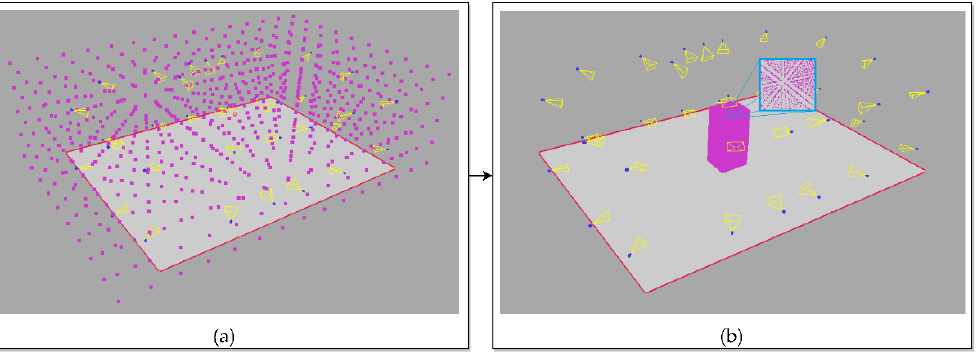
Figure 3. Estimation of the subject’s volume: ( a ) the initial voxel grid with voxel size D 0 in the volume of the system cameras; ( b ) the voxel grid with voxel size D 1 of the subject’s volume.